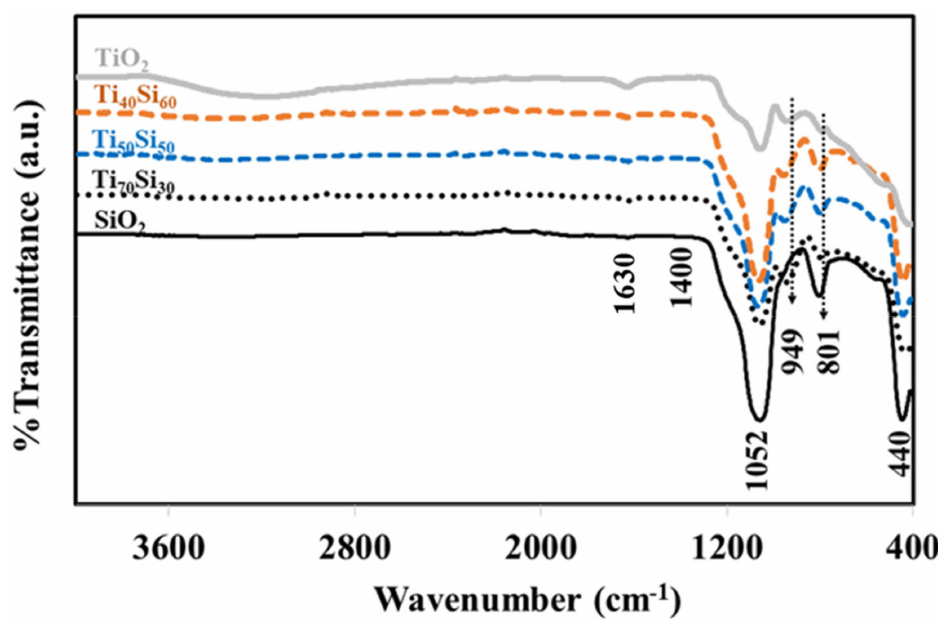
Figure 14. FTIR spectra of TiO 2 , SiO 2 , and Ti x Si y oxide synthesized at pH 9.0 with different Ti/Si ratios. The FE-SEM image of TiO 2 exhibits a large majority of particles with high agglomera- tion, as shown in Figure 15a. Ti 70 Si 30 and Ti 50 Si 50 oxides show particles that are homoge- neous with a good nanostructure and mostly spherical in shape when Ti/Si is more than 1 (Figure 15b,c). However, the size of Ti 40 Si 60 oxide particles becomes gradually aggregated with increasing moles of Si (Figure 15d).